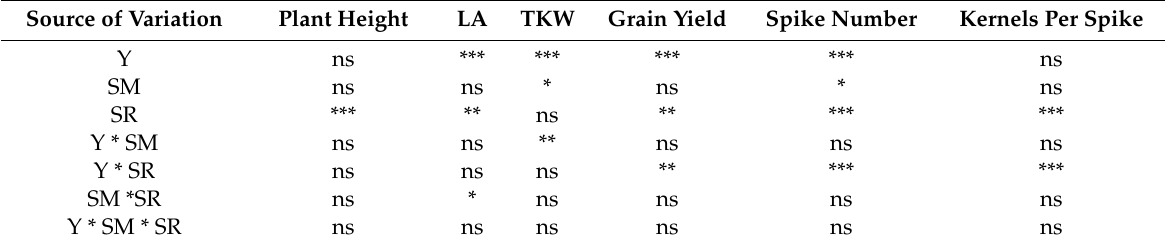
Table 4. Analysis of variance for the wheat quality traits as a ff ected by year (Y), sowing methods (SM), seed rate (SR), and their interactions for the field experiments conducted in 2017–2018 and 2018–2019.